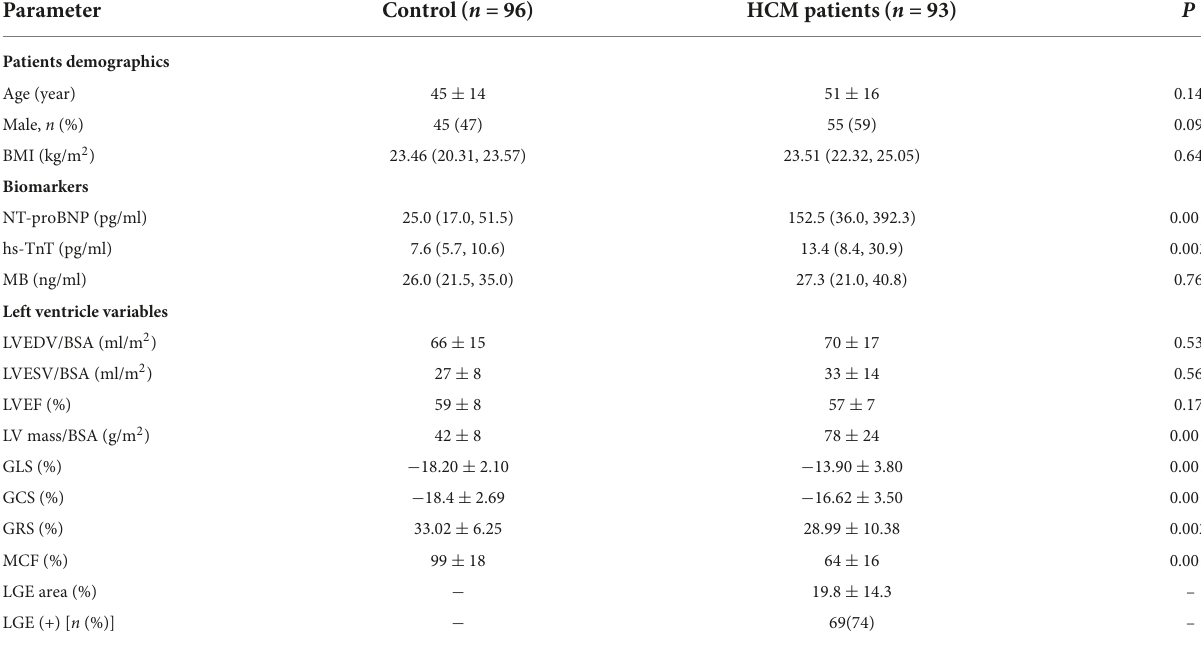
TABLE 1 Comparison of clinical and imaging parameters of the study population. Parameter Patients demographics